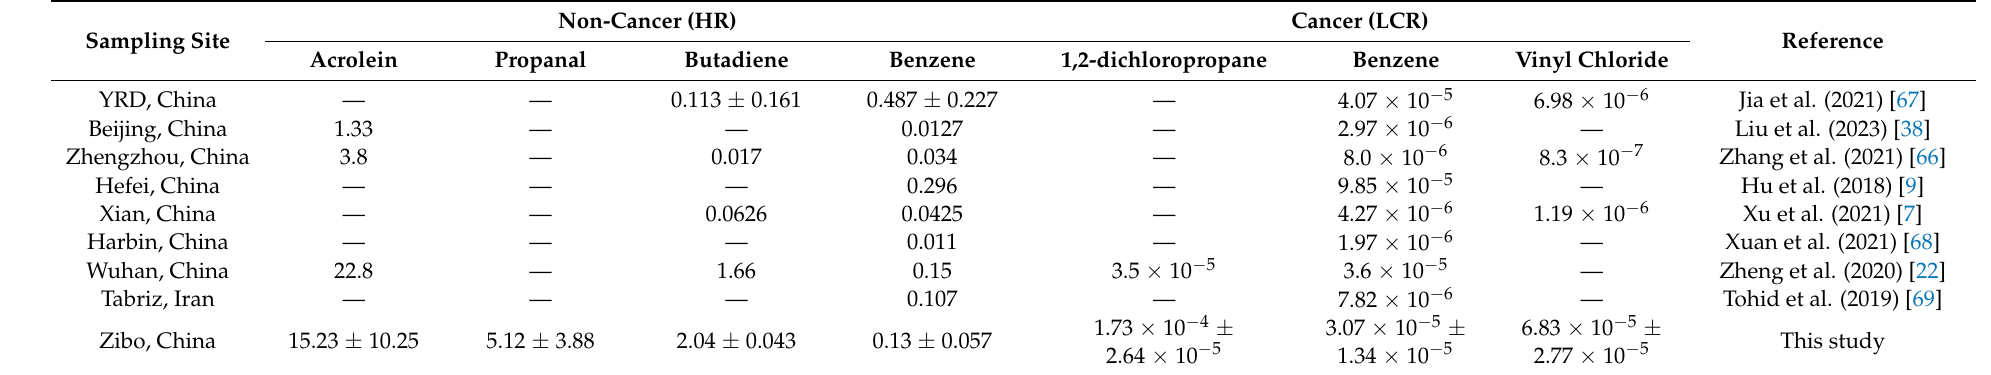
Table 2. Comparison of cancer and non-cancer risks of specific VOCs in different